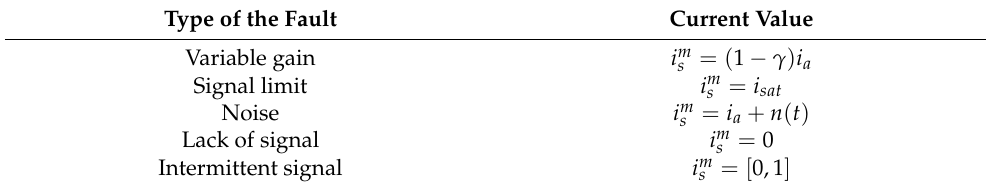
Table 1. Equations to simulate individual failures of current sensors.